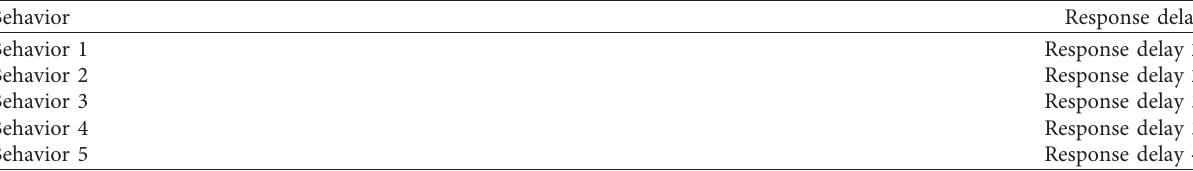
Table 6: Pedestrians behavior.